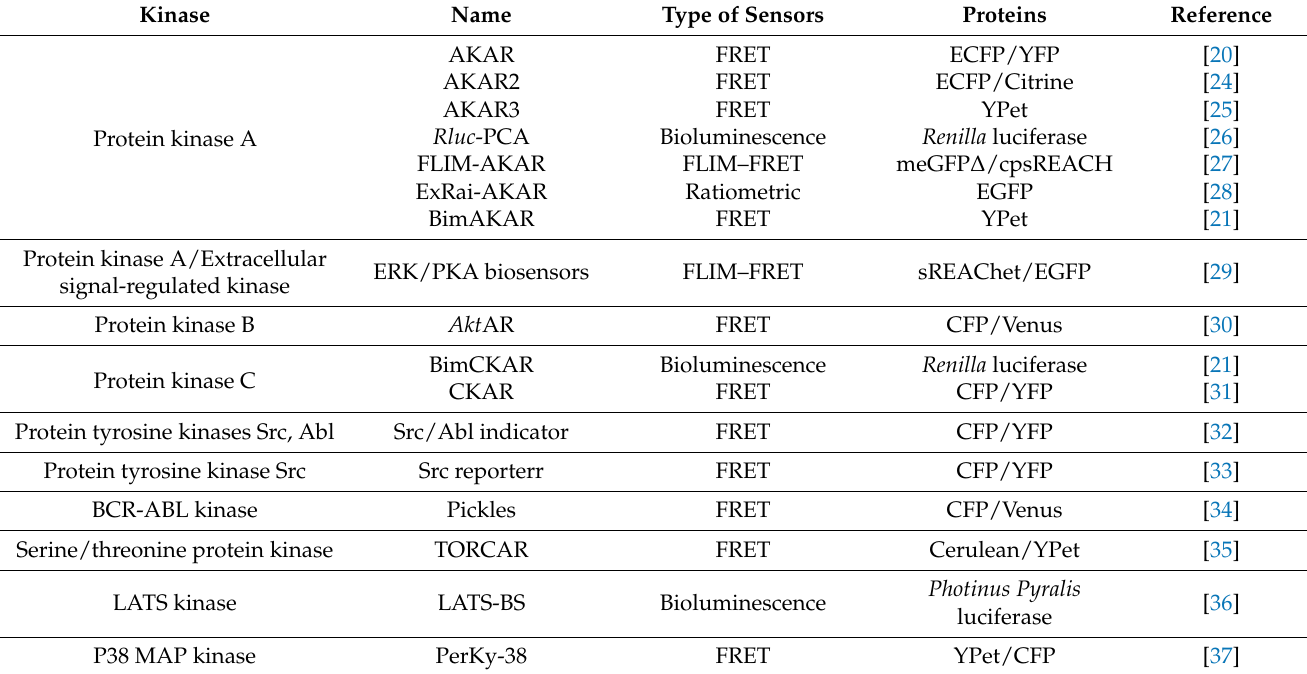
Table 1. Genetically encoded fluorescent biosensors for protein kinase studying in cancer.